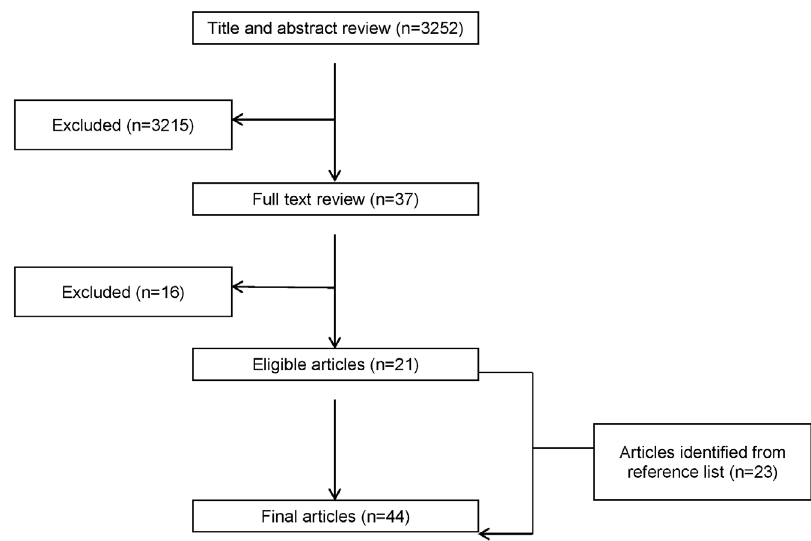
Figure 1. Summary of literature search and selection.